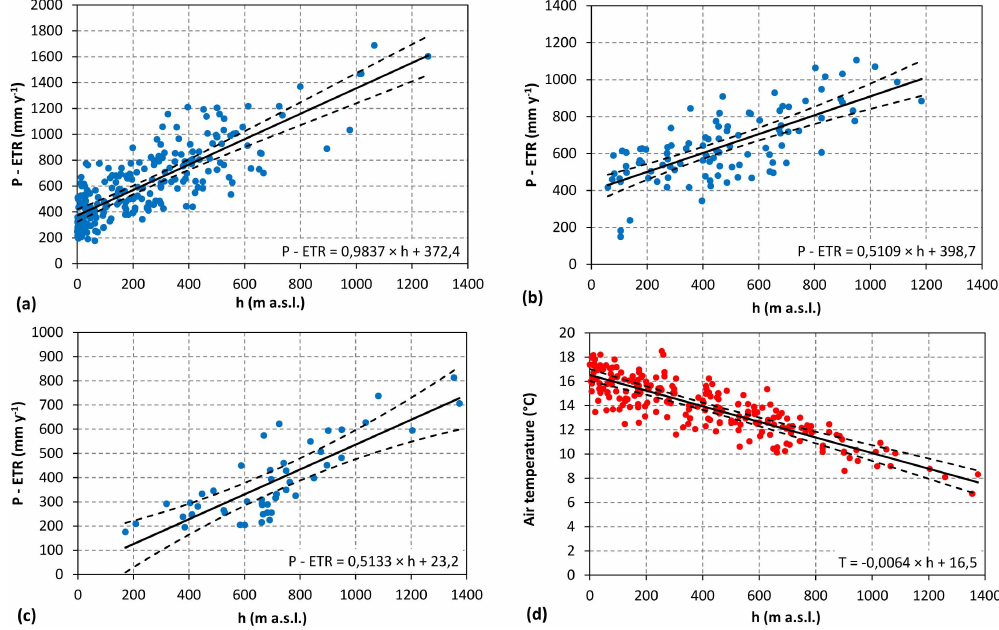
Fig. 5. Linear correlations and confidence limits (95%) between mean annual P − ETR and altitude for upwind zone (a) , first downwind zone (b) and second downwind zone (c) . The correlation between mean annual air temperature and altitude is also shown (d)